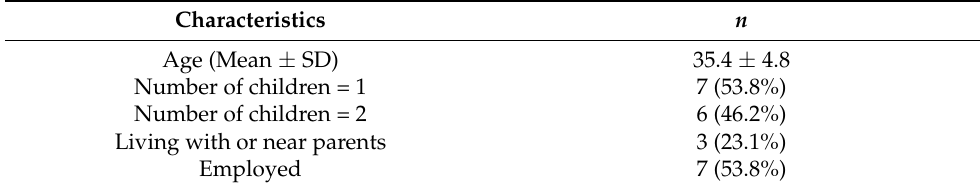
Table 1. Characteristics of the participants ( n = 13).